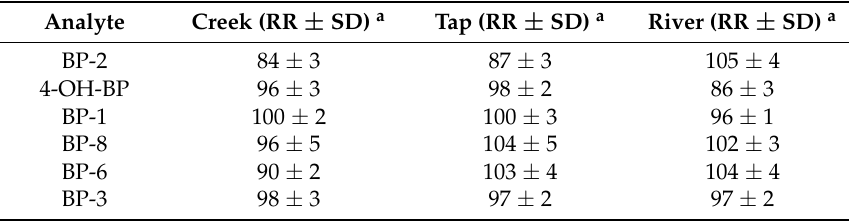
Table 3. The analysis of water samples spiked with the target